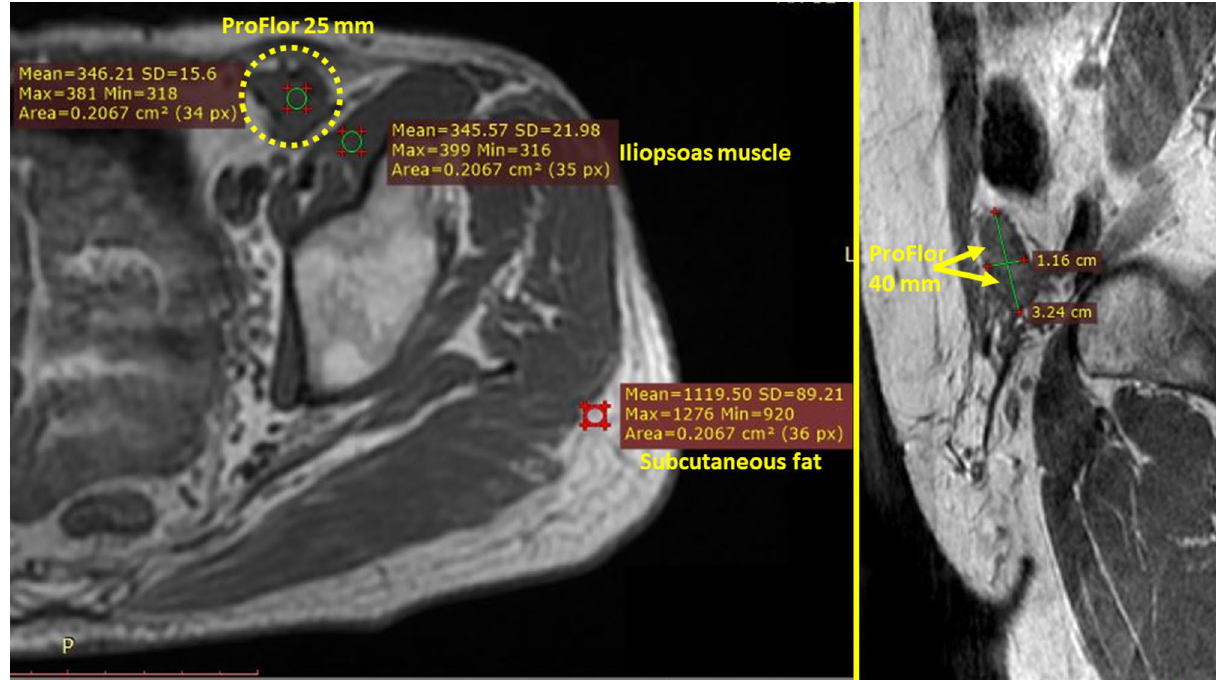
Figure 9. ( A ) Axial T1 SE MR image of the pelvis. ( A ) Patient with left inguinal hernia defect repaired with 25 mm ProFlor 9 months after implantation. 3D scaffold (yellow circle) occupies former hernia defect in the groin and appears wholly integrated into the inguinal backwall. 3D structure appears fully incorporated by newly ingrown tissue. The mean signal intensity (SI) of the newly developed tissue within ProFlor is nearly identical to the SI of the neighboring left iliopsoas muscle. Subcutaneous fat tissue of the lateral abdominal wall shows significantly higher SI. ( B ) Detail of sagittal T1 SE MR image of the pelvis showing a 40 mm ProFlor 12 months after implantation. 3D hernia device (yellow arrows) fully obliterates the defect. Transverse thickness of 3D scaffold, originally 15 mm, under steady pressure of visceral content, is reduced to approx. 11 mm, which is comparable to the thickness of the muscular barrier of the groin. Diameter of ProFlor, originally 40 mm, being squeezed within the former hernia defect now measures 32